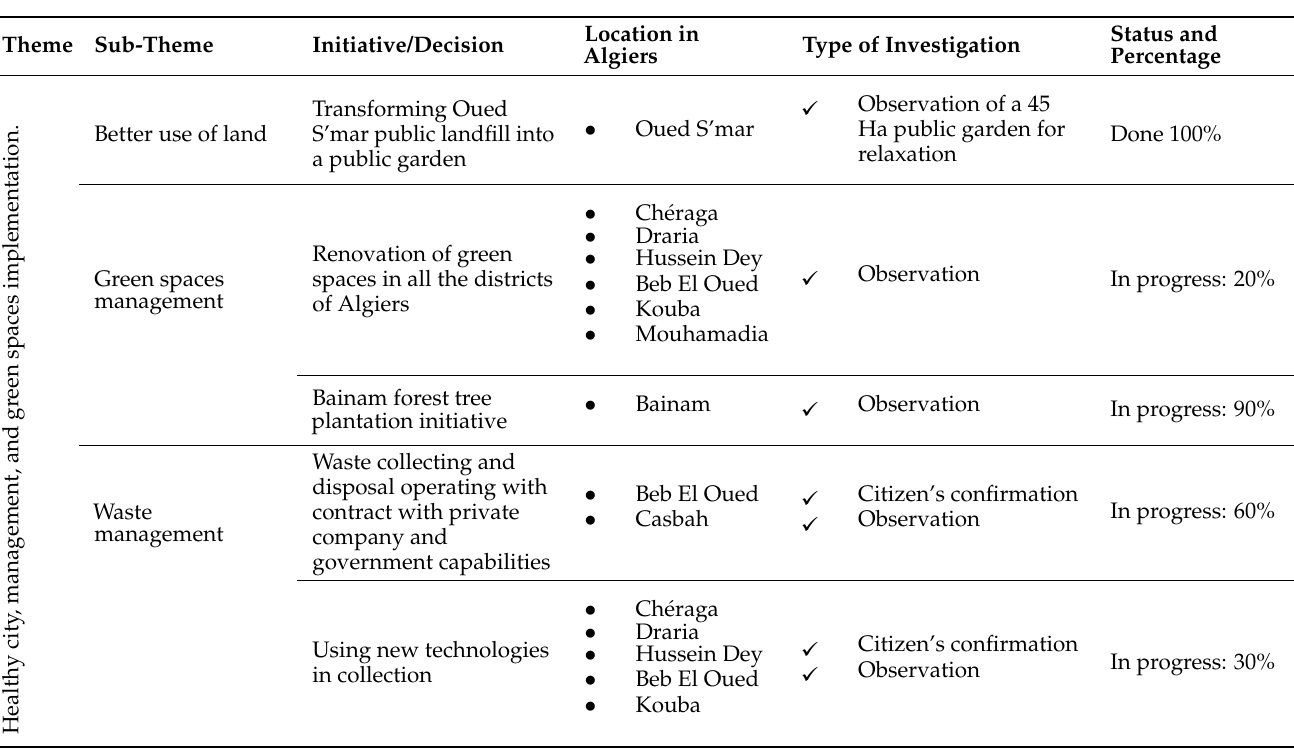
Table 4 . On-site investigation